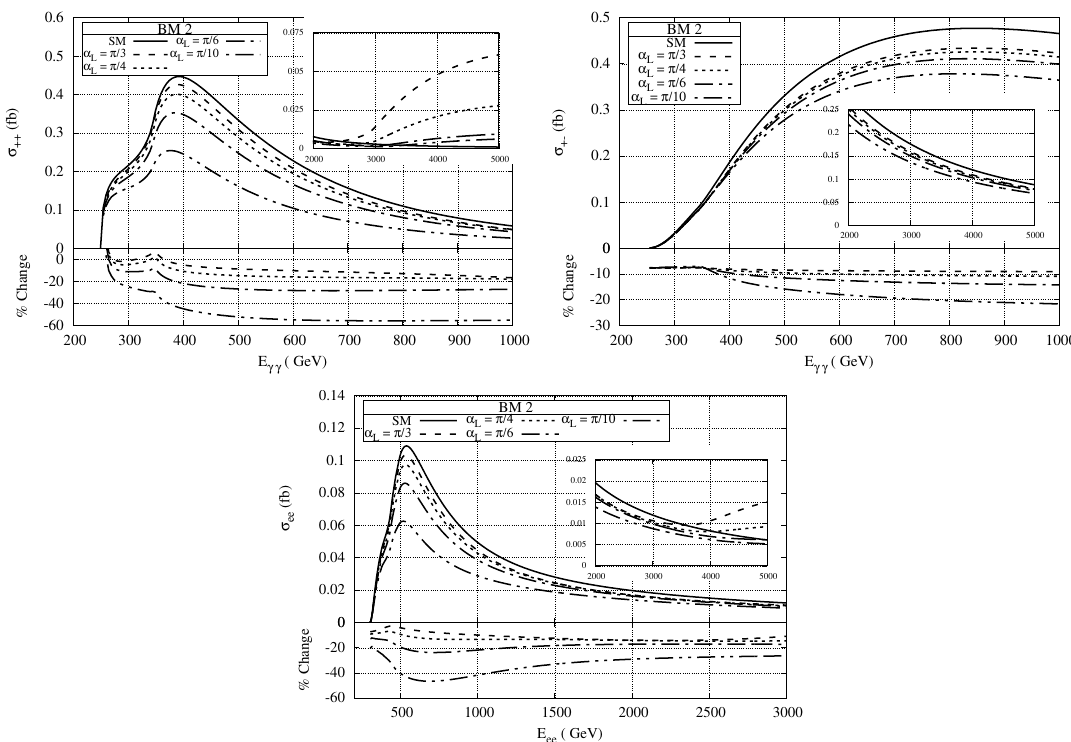
Figure 12 . γγ → hh cross-section for same photon helicities (top left panel), opposite photon helicities (to right panel) and e + e − → hh (bottom panel) model having additional doublet of top and bottom partners. The BM2 point parameters are given in table 7.